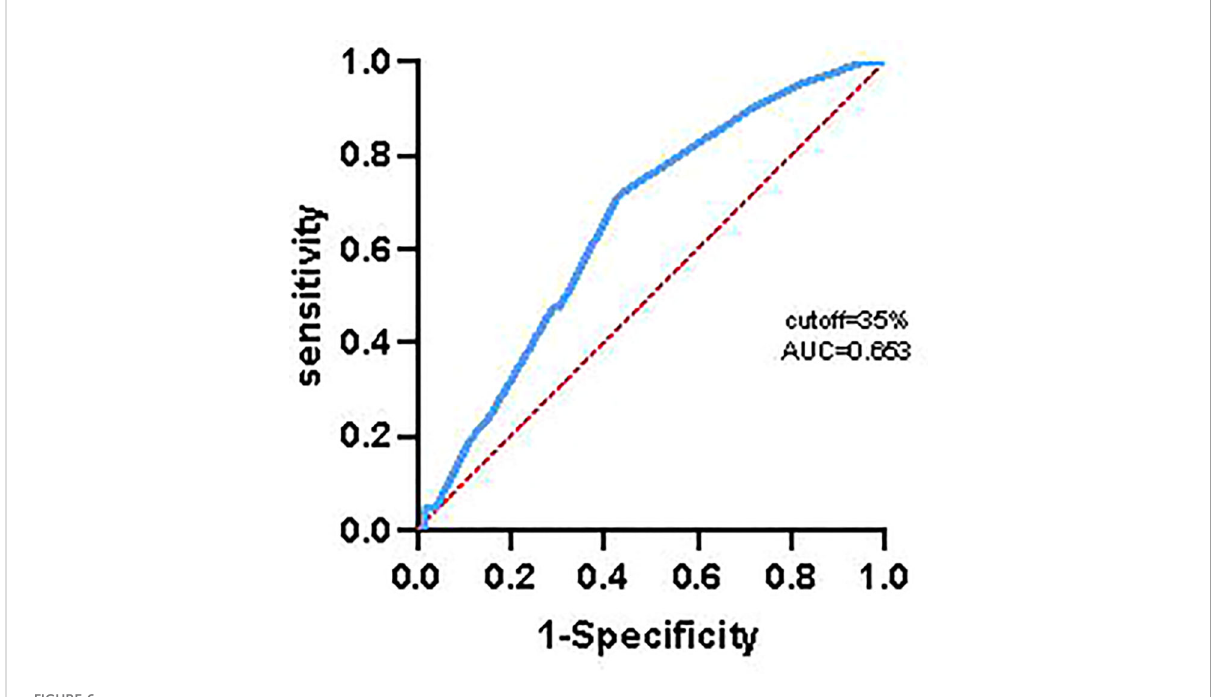
FIGURE 6 Ki67 of receiver operating characteristic curve.